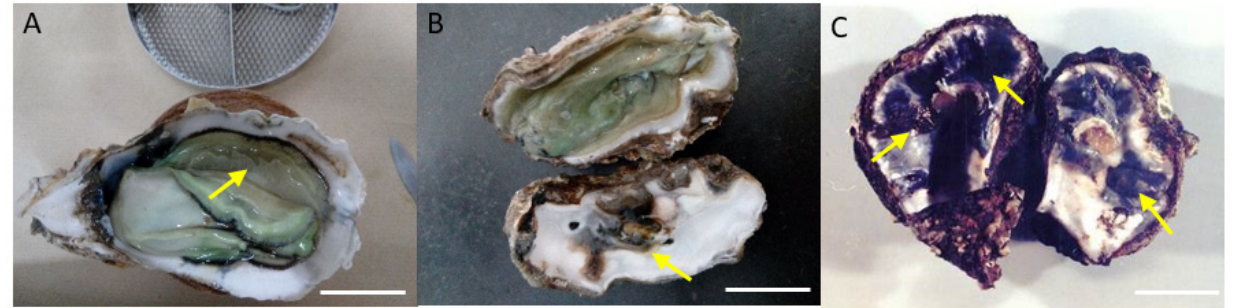
Figure 3. Macroscopical lesions observed in oysters. ( A ) Gills lesions (arrow) in C. angulata (bar = 3 cm). ( B ) Shell disease (arrow) in C. angulata (bar = 3 cm). ( C ) Mud blisters (arrows) in C. gigas (bar = 3 cm).